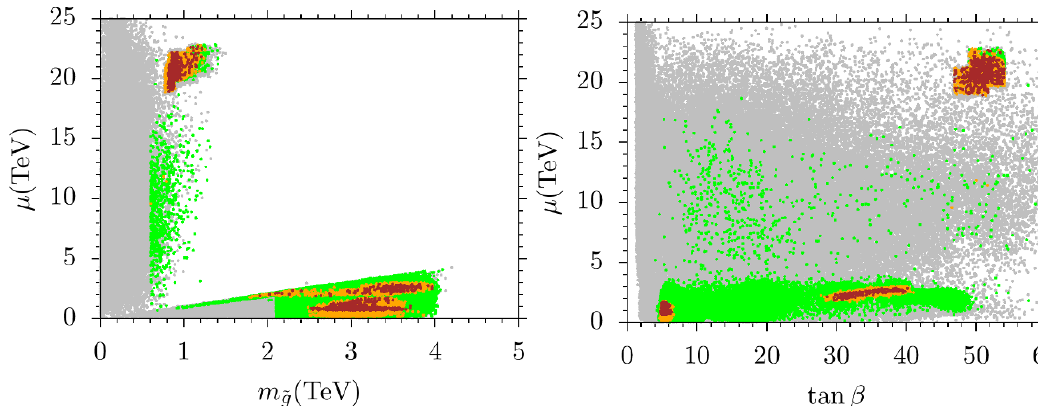
Figure 4 . Plots in the (cid:22) (cid:0) m ~ g and (cid:22) (cid:0) tan (cid:12) planes. All points are consistent with the REWSB and LSP neutralino conditions. Green points satisfy the mass bounds and the constraints from rare B (cid:0) meson decays. Orange points form a subset of green and the are compatible with the b (cid:0) (cid:28) YU condition. Brown points, as a subset of orange, are allowed within 5 (cid:27) by the WMAP bound on the relic abundance of LSP